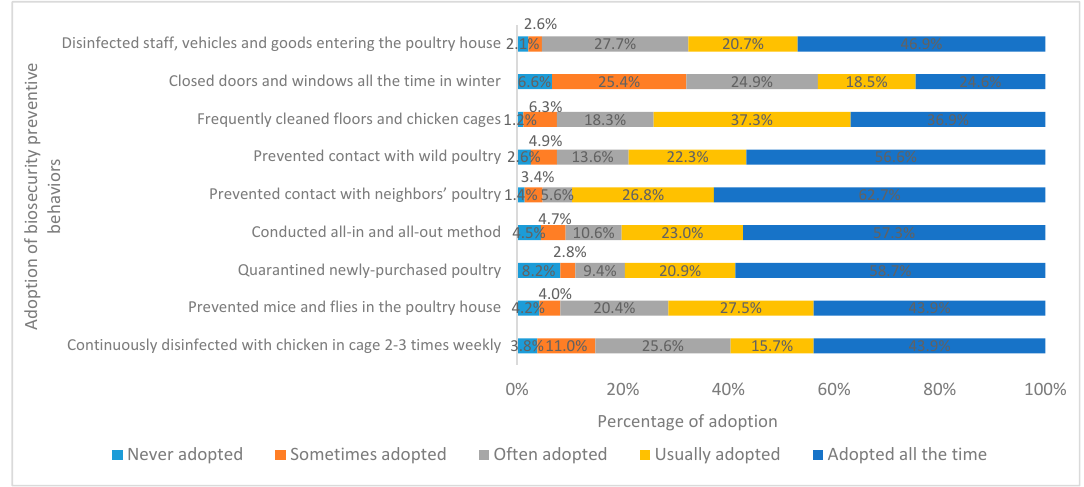
Figure 3. Percentage of respondents reporting adoption of biosecurity preventive behaviors against avian influenza (AI).